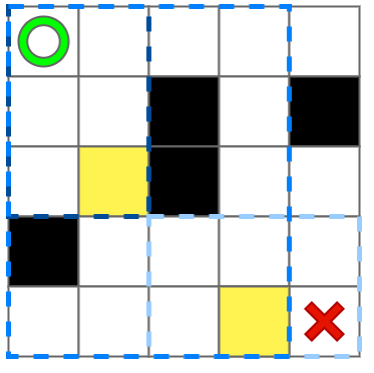
Figure 4. The grid map with intermediate